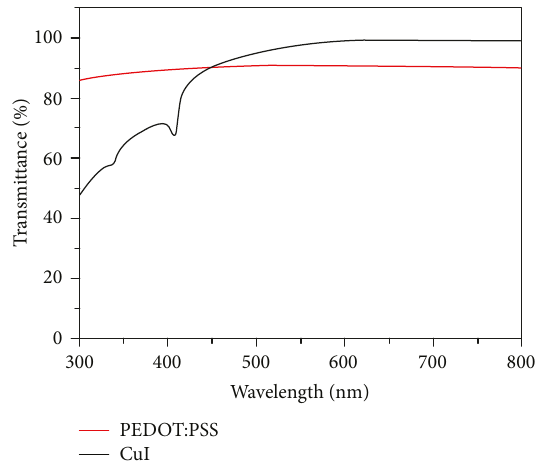
Figure 5: Optical transmission spectra of the PEDOT:PSS fi lm and CuI fi lm. Reprinted with permission from